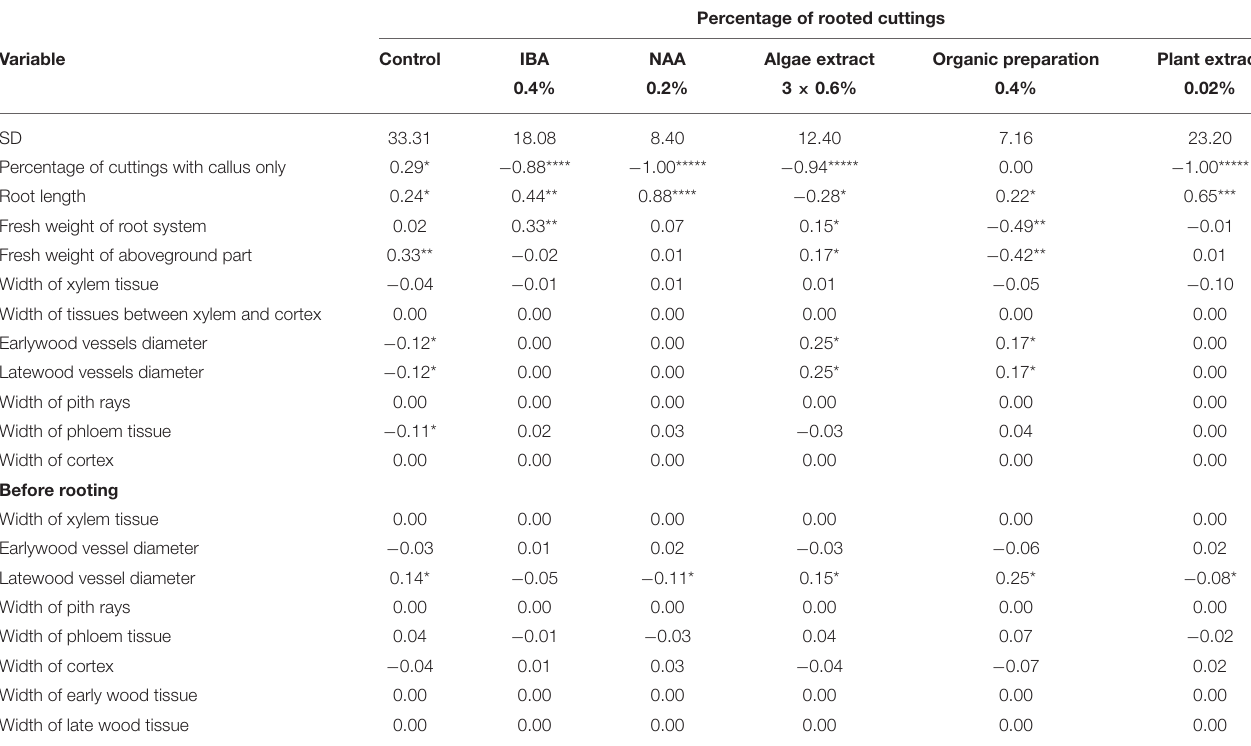
TABLE 3 | Effect correlations between percentage of rooted cuttings and measured parameters of growth and anatomical structure in Rosa “Hurdal” before and after 25 days of rooting cuttings derived from shoots H1, with flower buds closed (BBCH 54